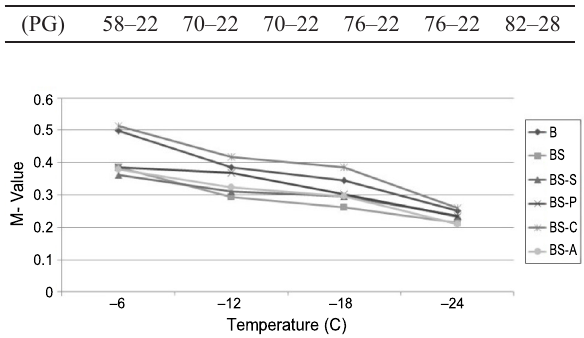
Fig. 11. M–value of binders at low temperature